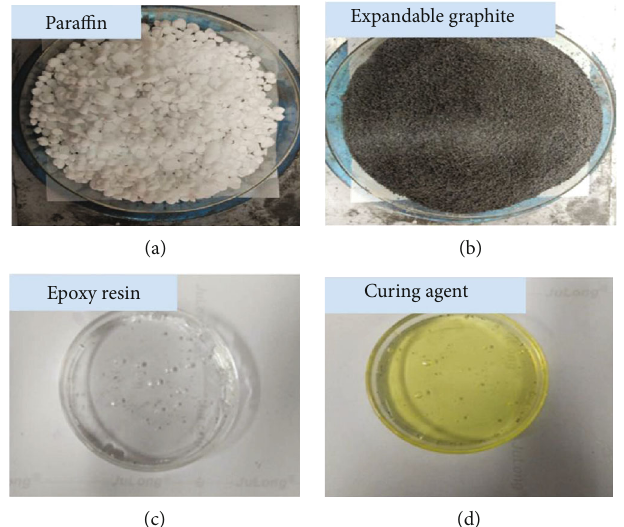
Figure 1: Photograph of the pristine materials prepared for composite PCM: (a) PA, (b) EG, (c) ER, and (d) curing